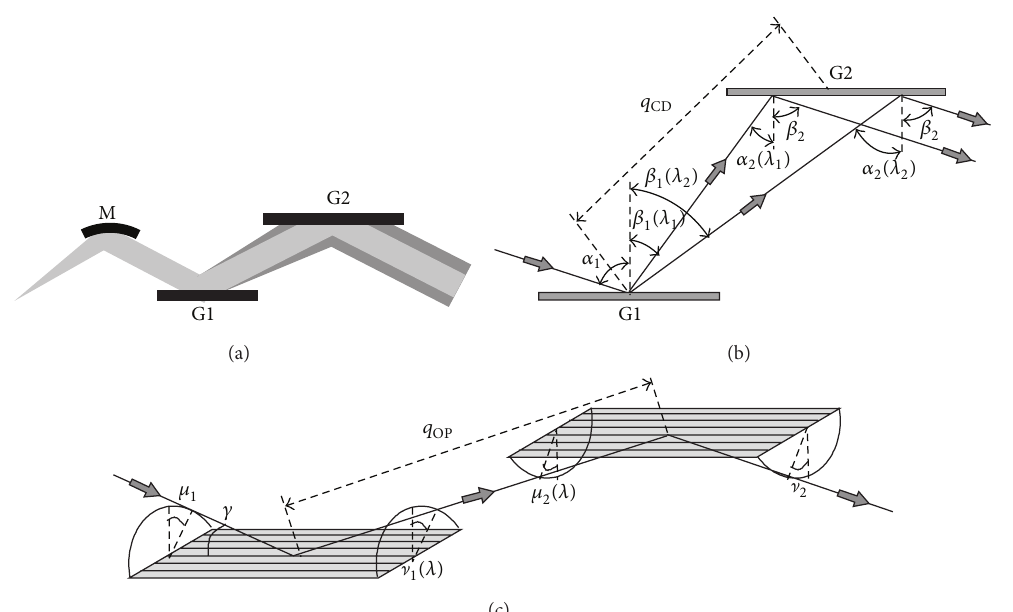
Figure 2: Plane double-grating compressor: (a) schematic view, including the collimating mirror (M), and the two gratings (G1 and G2); (b) classical-diffraction mount; (c) off-plane